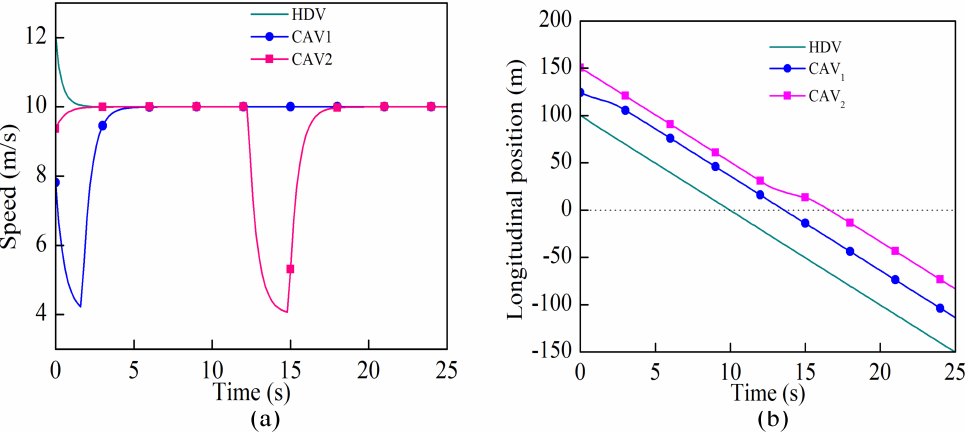
Figure 6. The speed and position curves of all the vehicles during the whole crossing; ( a ) the speed, ( b ) the position.